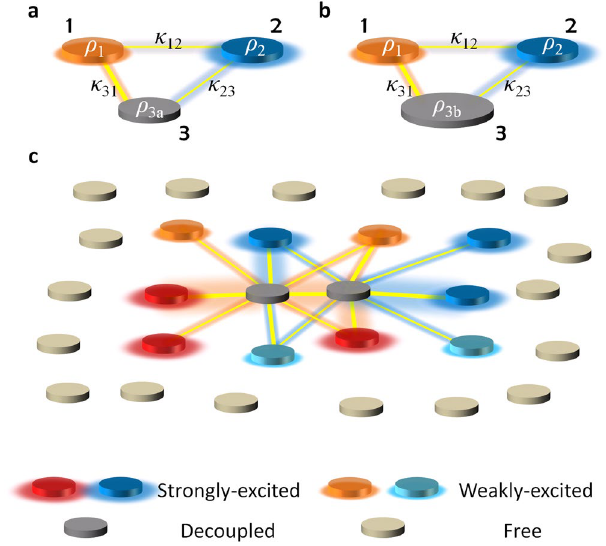
Figure 1. Schematics of the designer state for the decoupling in coupled optical systems. Tri-atomic examples for different self-energy at the 3 rd element: ( a ) ρ 3a and ( b ) ρ 3b . ρ for self-energy of each element and κ for the coupling between elements in ( a,b ). (c) N -atomic example for two target decoupled elements at the center (dark gray). Coupling is denoted as the line between elements, and for clarity, coupling terms only around the target elements are